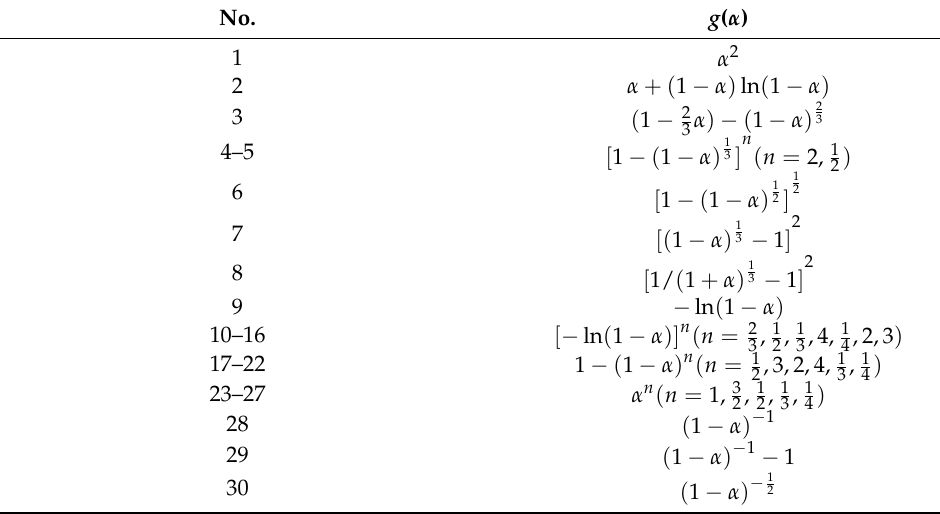
Table 2. The functional expressions of 30 kinetic models g ( α ).